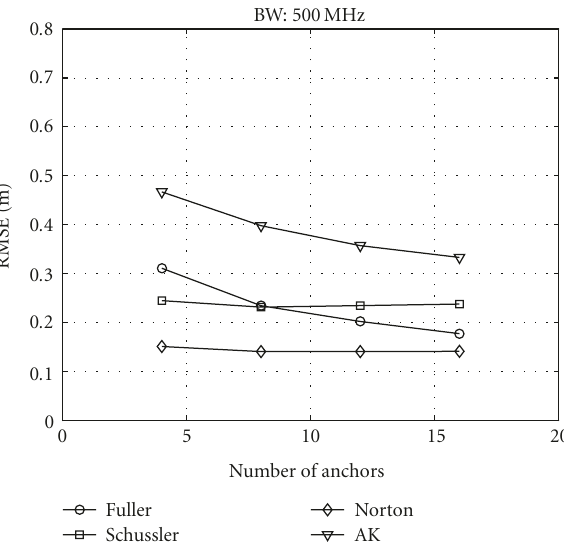
Figure 5: Localization performances as a function of node density in di ff erent indoor environments using 500 MHz models. Figure 6: Localization performances as a function of number of anchors in di ff erent indoor environments using 500MHz